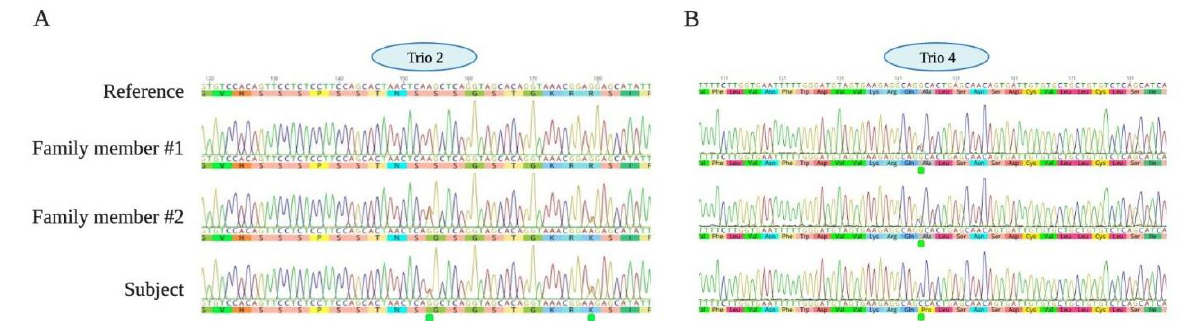
Figure 1. Two examples of candidate gene sequences from ( A ) Trio 2 and ( B ) Trio 4. Reference genomic sequences with the amino acid sequence are shown on top. The variants in subjects are highlighted by a green marker. ( A ) The family member who shared the subject’s genotype in Trio 2 also had higher scores in the severity of dependence. ( B ) The subject was homozygous for a variant that both parents (Family members #1 and #2) were heterozygous for.